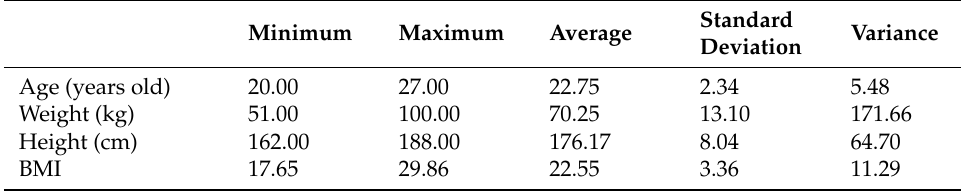
Table 2. Differences in subjects’ age, weight, height, and BMI